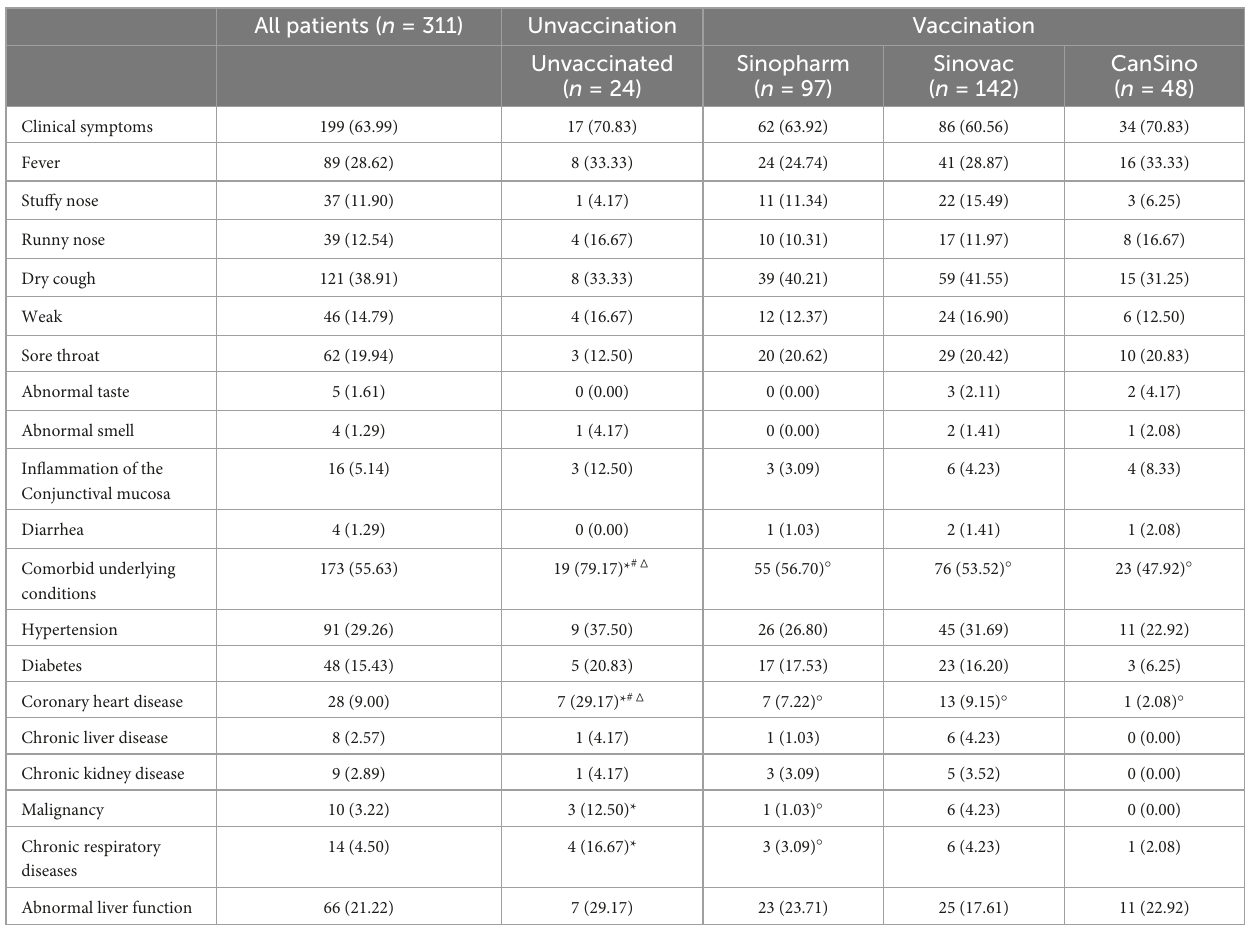
TABLE 2 Clinical characteristics of convalescent adult patients in different groups. All patients ( n = 311) Unvaccination Vaccination